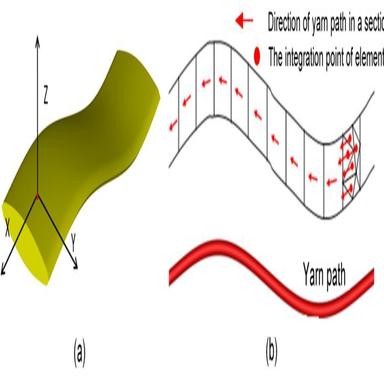
The coordinate of yarn: (a) Definition of local coordinates; (b) Definition of material direction.